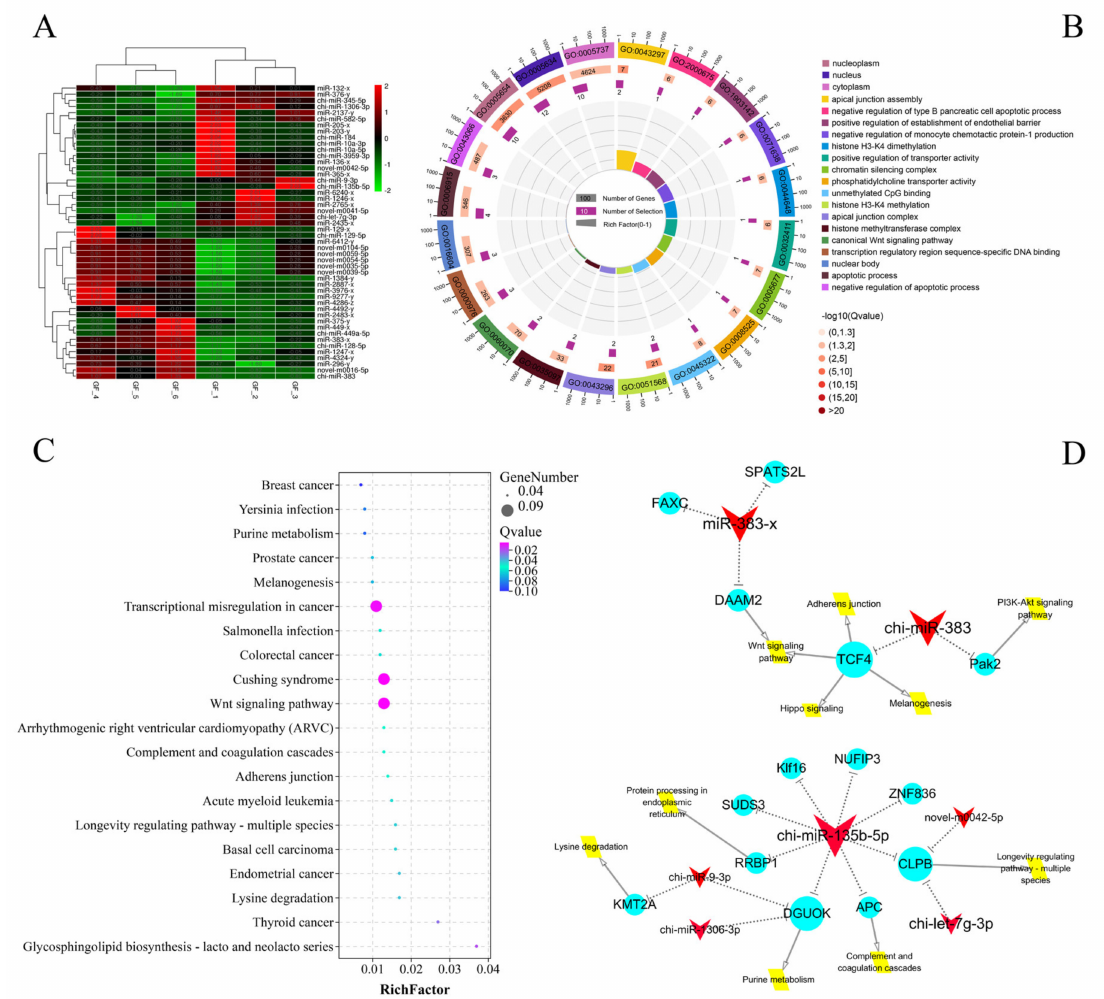
Figure 2. Functional analysis DEmiRNAs between LFs and SFs of Dazu black goats: ( A ), clustering heat map of 49 DEmiR- NAs; red represents up-regulated expression and green represents down-regulated expression; ( B ), top 20 terms of GO enrichment analysis; ( C ), top 20 pathways of KEGG enrichment analysis; and ( D ), key miRNA regulation network in DEmiRNAs between LFs and SFs of Dazu black goats; red represents DEmiRNAs, blue represents DEmRNAs, and yellow represents the major pathways; the size represents the number of DEmiRNA-TGs, i.e., a larger size means greater number of